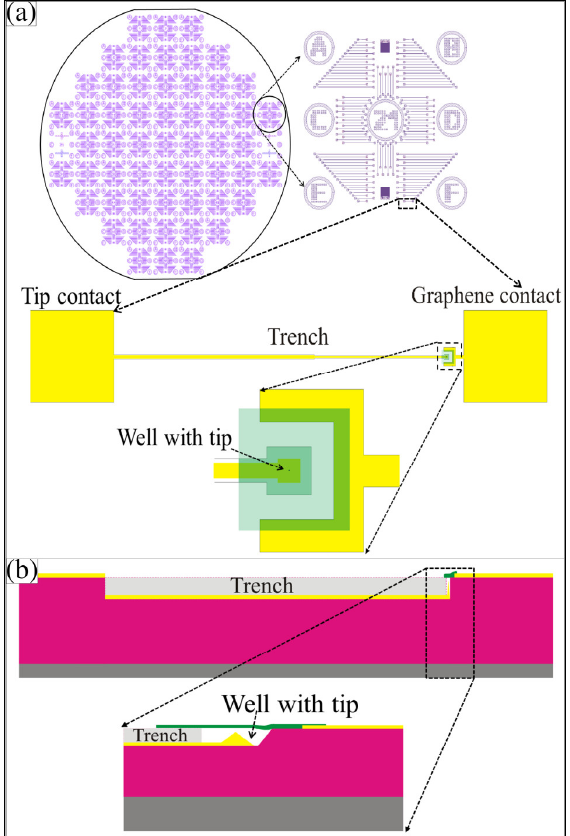
Figure 2. Schematic illustration of the wafer layout. ( a ) 100 mm silicon wafer with an array of 57 identical patterns next to a zoomed-in view of a single 1 cm square unit. Notice each 1 cm unit has regions A-F labeled for easy record keeping. A top view illustration of a single graphene membrane variable capacitor with metal contacts is also shown. ( b ) Cross-sectional side view and a zoomed-in side view of a single graphene membrane variable